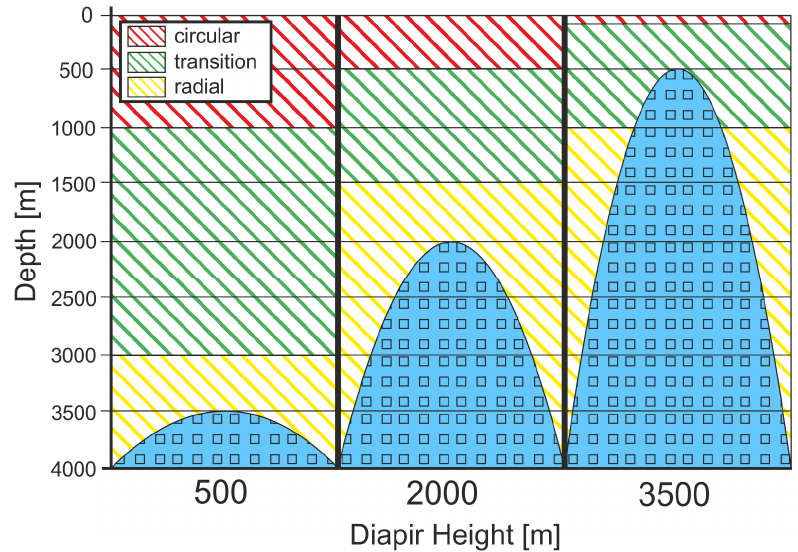
Figure 14. Distribution of the pattern of S Hmax around and above the salt diapir with regard to the diapir height (Model B-03–B-05). The yellow hatched areas show the radial pattern (e.g., Figure 6b), the red hatched areas show the circular pattern (e.g., Figure 6d) and the green hatched areas show the transition zone between these two patterns.